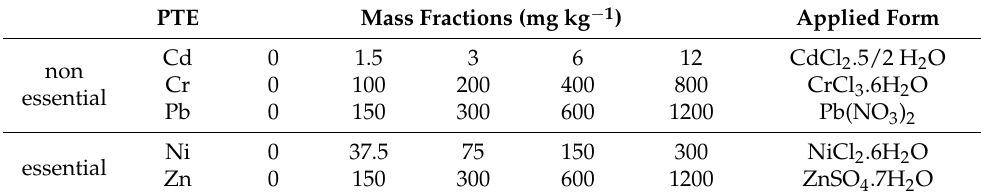
Table 2. PTE mass fractions used in the pot